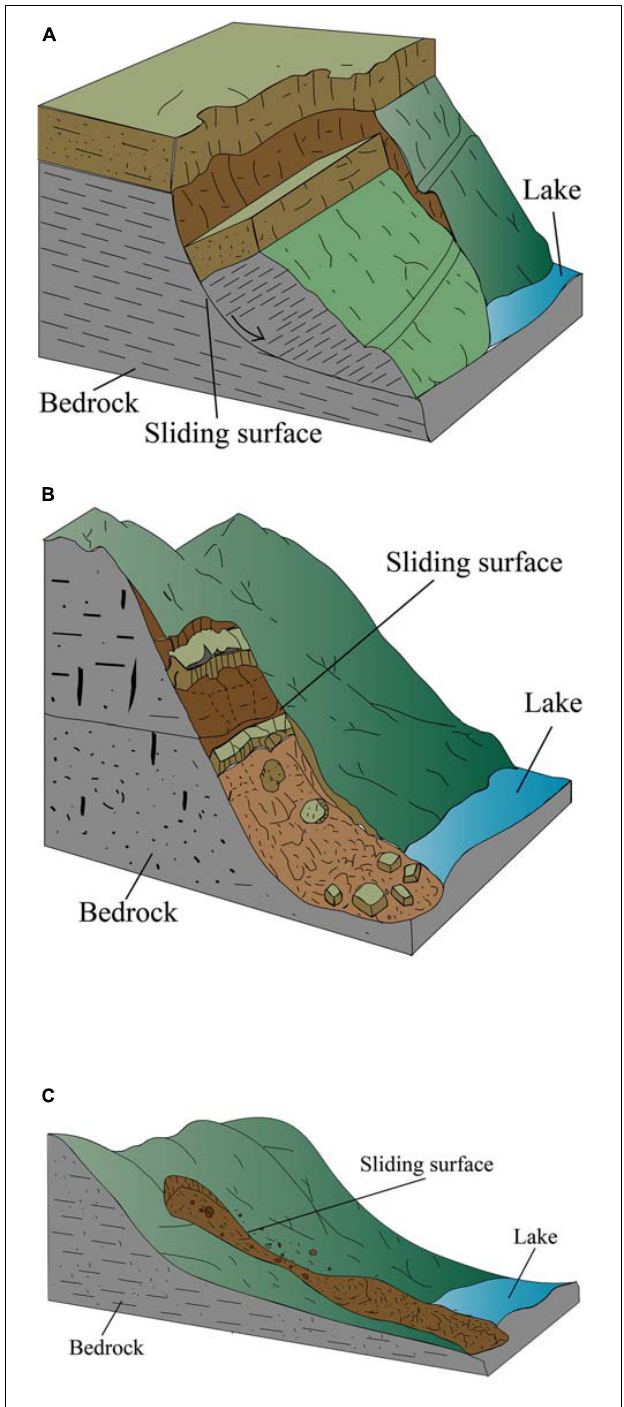
FIGURE 2 | Formation of landslide dams: (A) dam formed by rockslides; (B) dam formed by rock avalanches; (C) dam formed by flow in unconsolidated